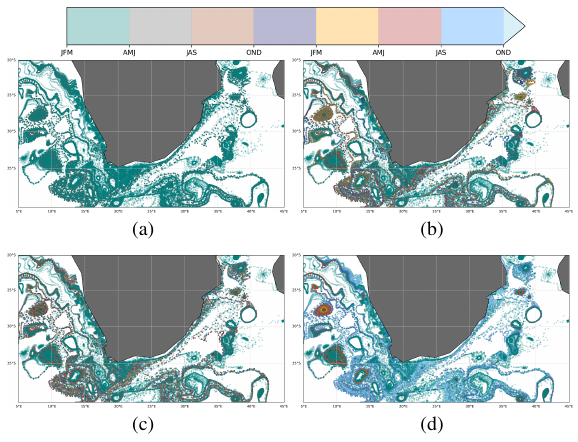
Figure 5. Illustration of the alpha-ordering problem: the plot shows particle densities similar to fig. 2(a), the individual particles are stored in random order. Plotting the data sequentially (as stored) can yield a highly-ordered (a) or arbitrary (b) alpha composition that occludes data points.